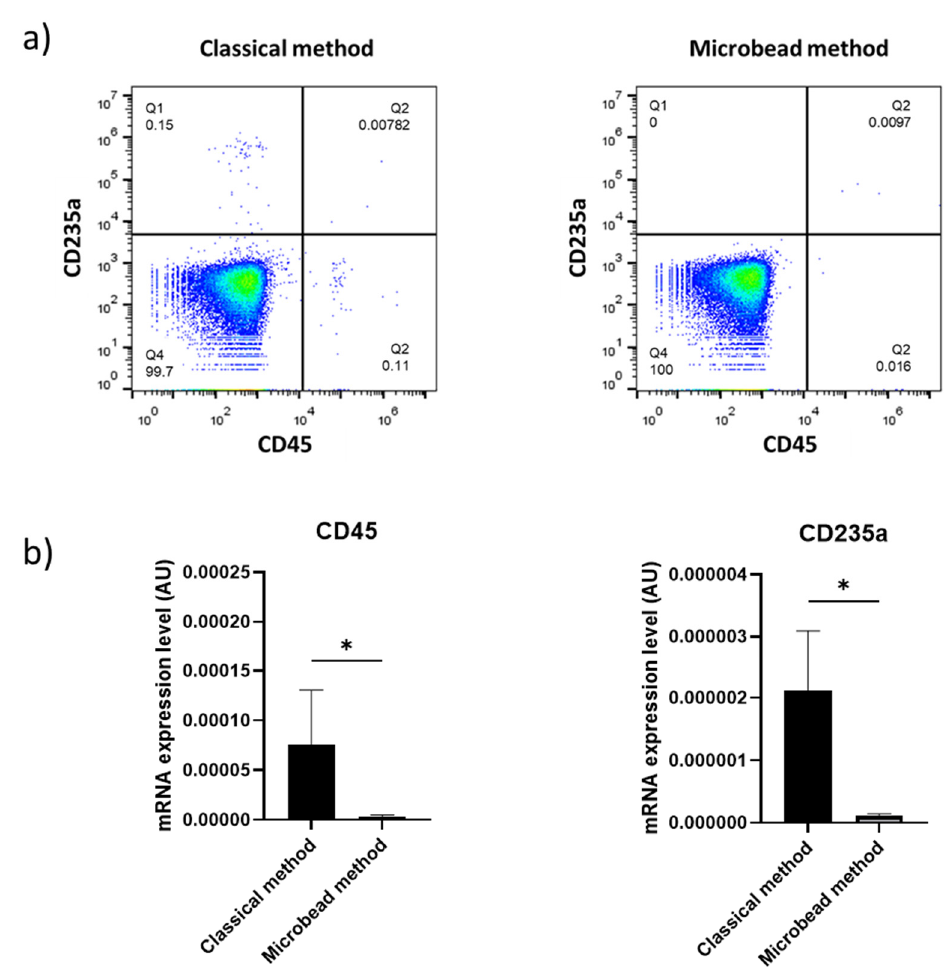
Figure 1. Platelet purity according to the purification method. ( a ) Flow cytometry analysis of platelets before and after the use of anti-CD45 and anti-CD235a magnetic microbeads to eliminate leukocytes and erythrocytes respectively. ( b ) RT-PCR quantification of CD45 and CD235a transcripts in total mRNA derived from platelets treated or not with magnetic microbeads. 18S was used as a reporter gene ( n = 8). Results are expressed as relative expression compared to 18S in arbitrary unit (AU). Attached star * indicate a p -value < 0.05.